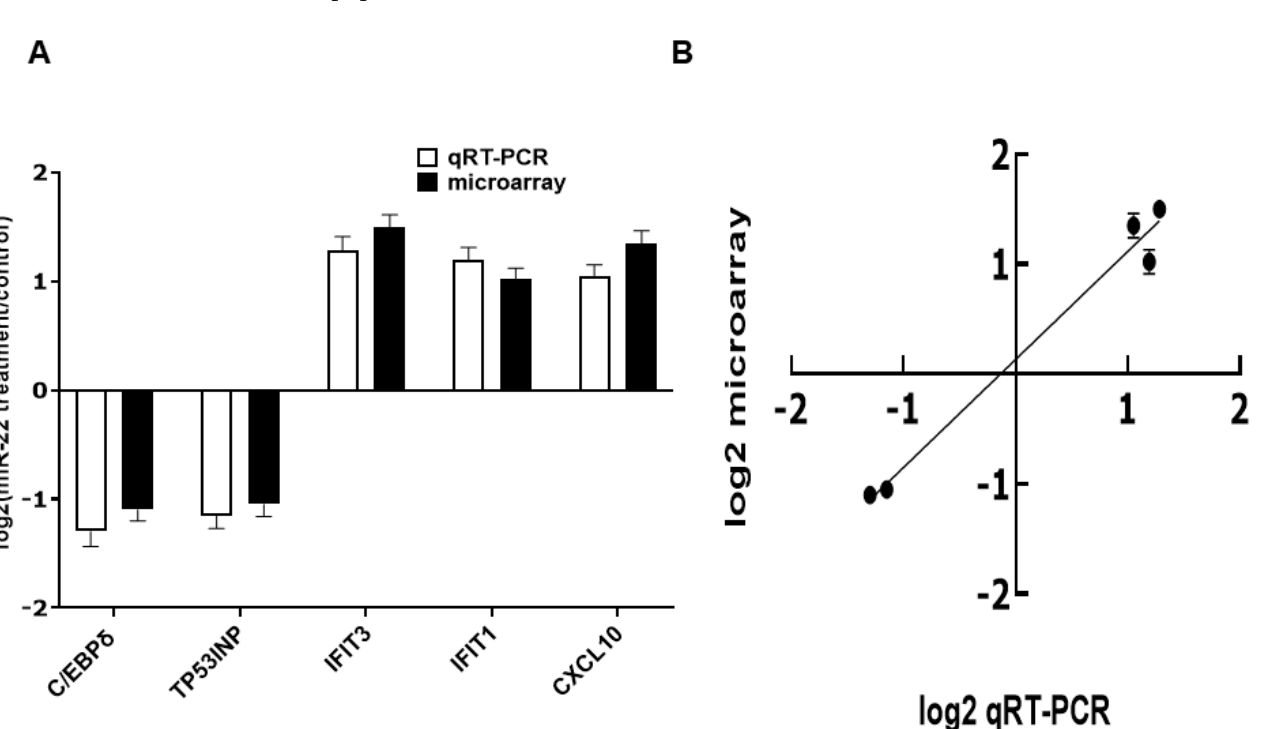
Figure 2. Real-time PCR verification of microarray results. ( A ) Results of qRT-PCR and microarray. ( B ) Correlation between results from microarrays and qRT-PCR. n = 5. Values are shown as mean fold-changes ± SD, relative to the control (set to 1). R 2 =